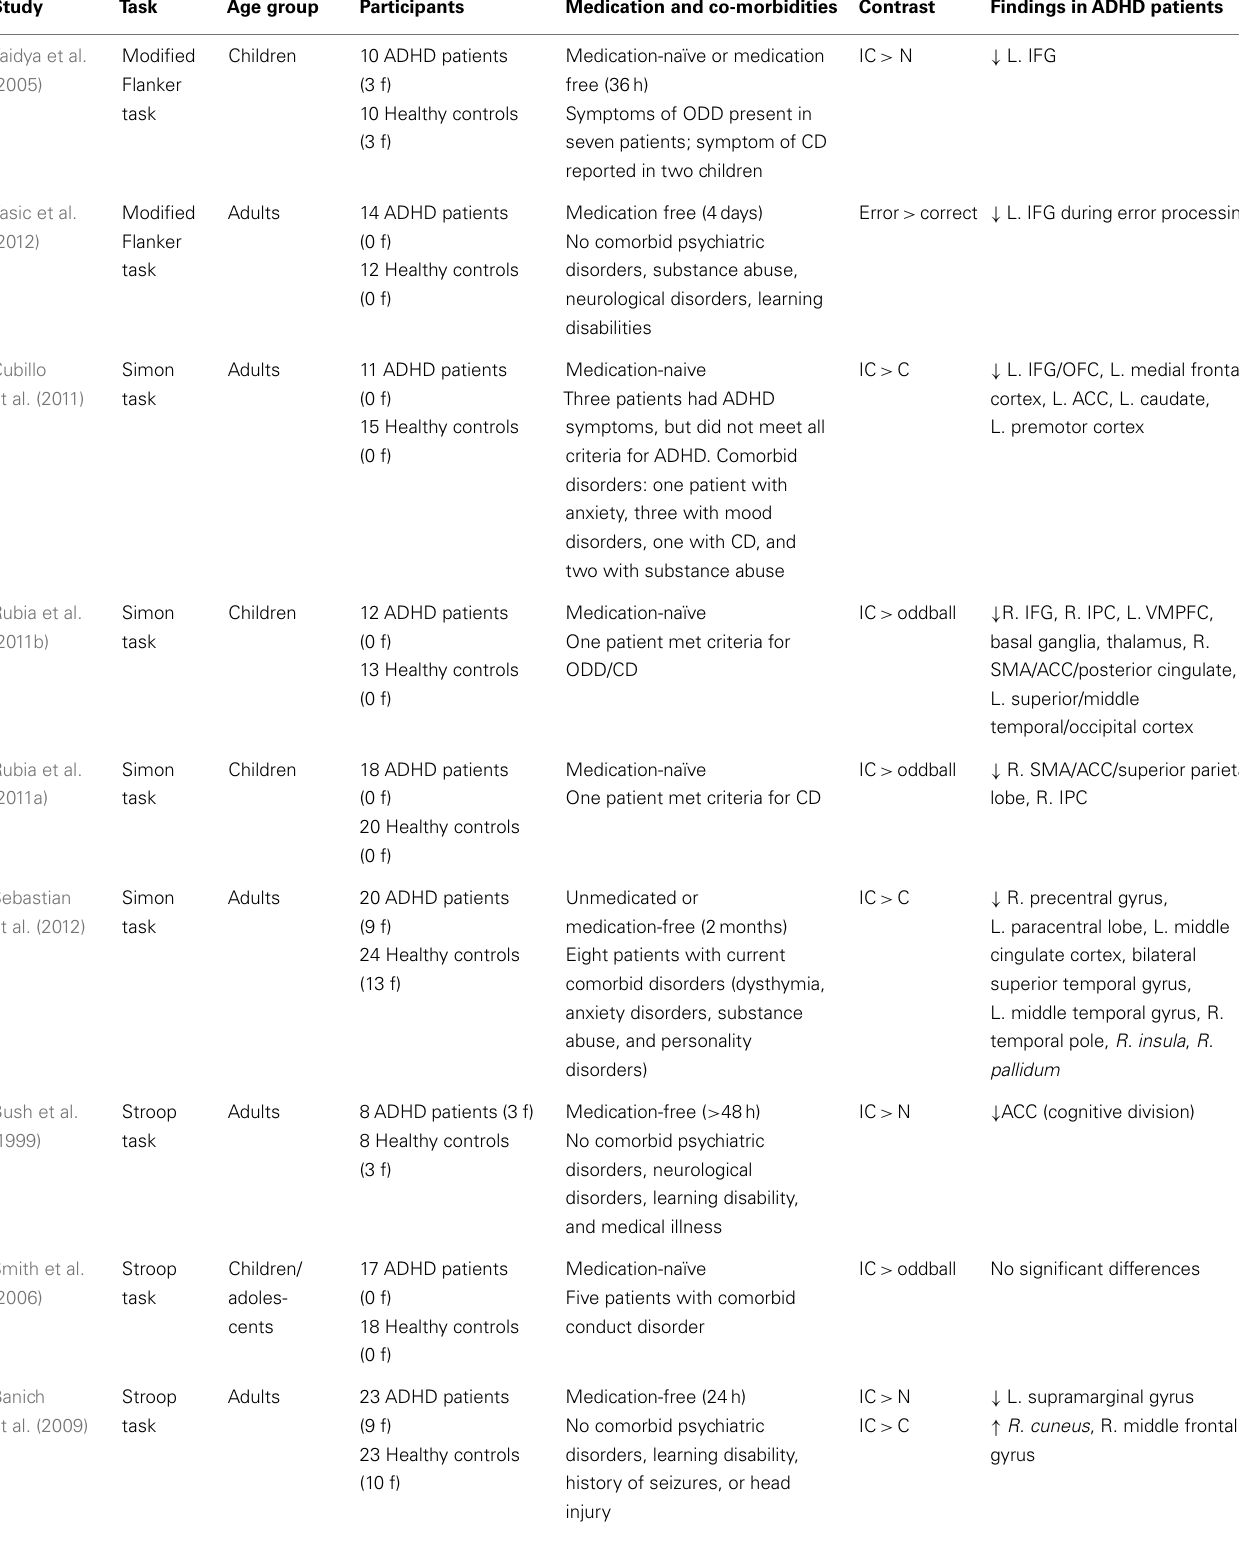
Table 4 | Overview of fMRI studies that have used interference control tasks in patients with attention-deficit hyperactivity disorder . Study Task Vaidya et